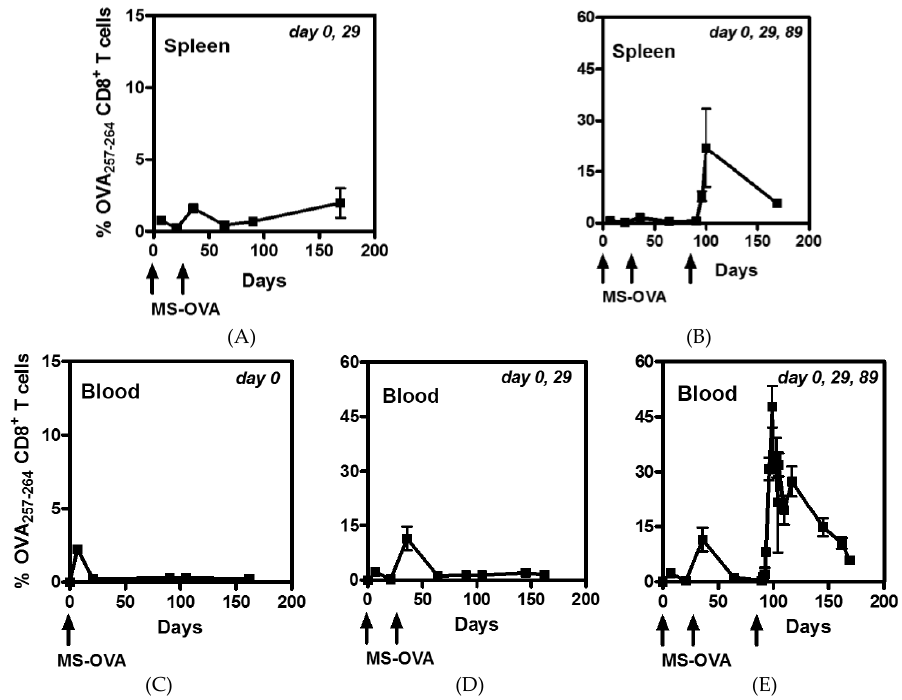
Figure 3. CD8 + T cell frequency following staggered prime-boost vaccinations with MS-OVA. C56BL/6 mice were vaccinated by s.c. injection with 20 µg of MS-OVA in the middle of the dorsal flank at day 0, 29, and 89 as indicated at the top of each panel. ( A , B ) Spleen ( n = 2/time point) and ( C – E ) blood (n = 3–5/time point) were collected before vaccination, seven days after and 21 days after each vaccination, as well as at later time-points. The blood was stained with anti-CD8 antibody as well as OVA 257–263 tetramer and analyzed by flow cytometry. Mice vaccinated three times had a greater median survival (91 days) than mice vaccinated once or twice (46 days), however the difference was not statistically significant. Overall, vaccinated animals survived significantly longer (log-rank, Mantel-Cox, p < 0.0001) than control mice, which had a median survival of 10 days (Figure 4).